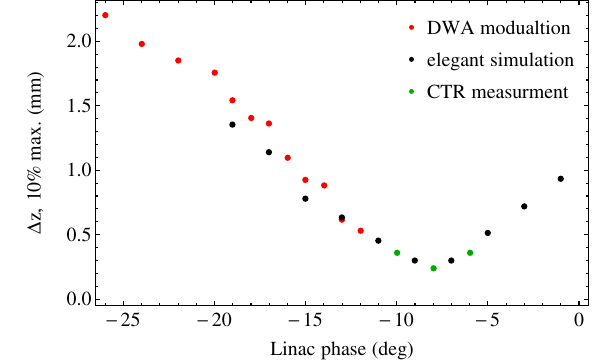
FIG. 43. Bunch length in BA1 measured at 10% of the peak level as a function of the linac off-crest phase: black dots, by using the energy modulation technique; green dots, by CTR diagnostic; red dots, ELEGANT simulations shifted toward the crest by